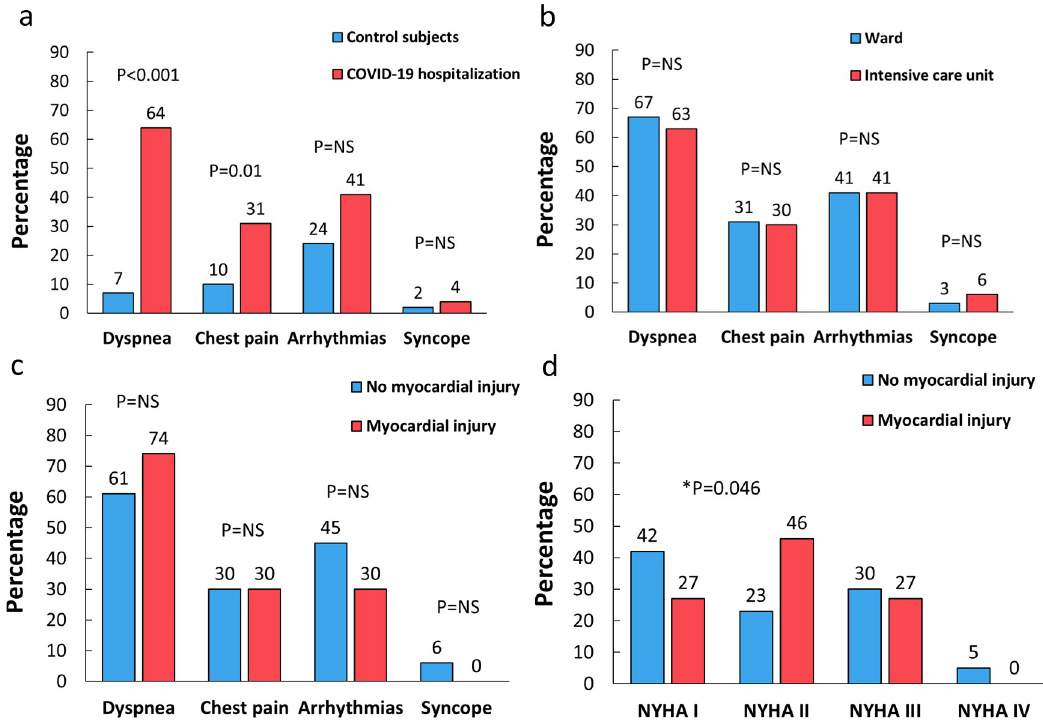
Fig 4. The Association of long-term symptoms with patient characteristics and cardiac magnetic resonance (CMR) imaging findings. Comparison of the symptomatic burden in patients with previous coronavirus disease 2019 (COVID-19) hospitalization and control subjects ( A ). Long-term symptoms in COVID-19 patients with and without intensive care unit treatment during hospitalization ( B ). The difference in symptomatic status in COVID-19 patients with and without a myocarditis scar on CMR imaging ( C ). New York Heart Association (NYHA) classification of dyspnea in patients with COVID-19 and a myocarditis scar on CMR ( D